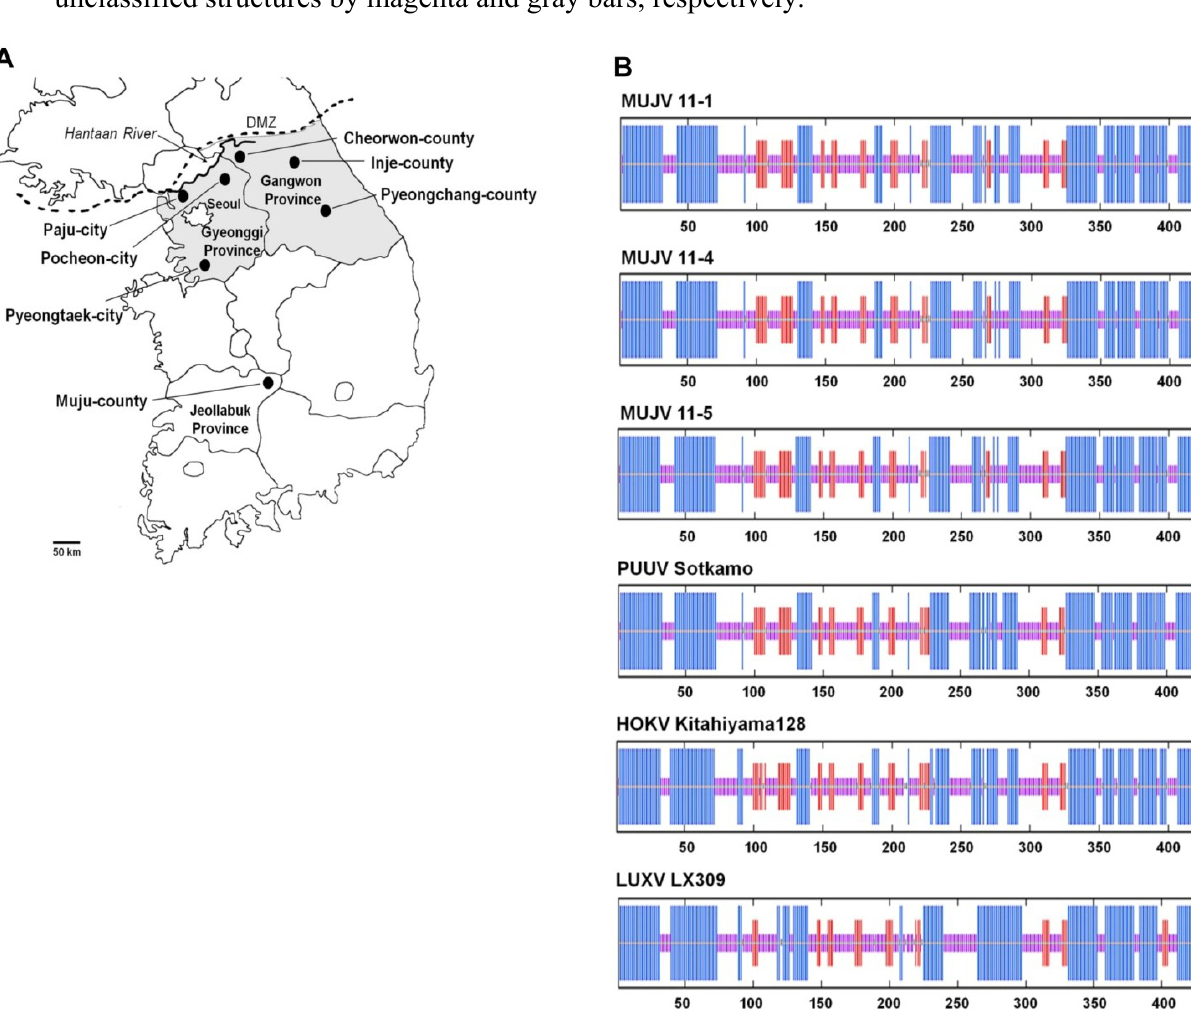
and LUXV, as predicted using several methods available at the NPS@ structure server [10]. Alpha helices are represented by blue bars, beta-strand by red bars, and random coils and unclassified structures by magenta and gray bars,